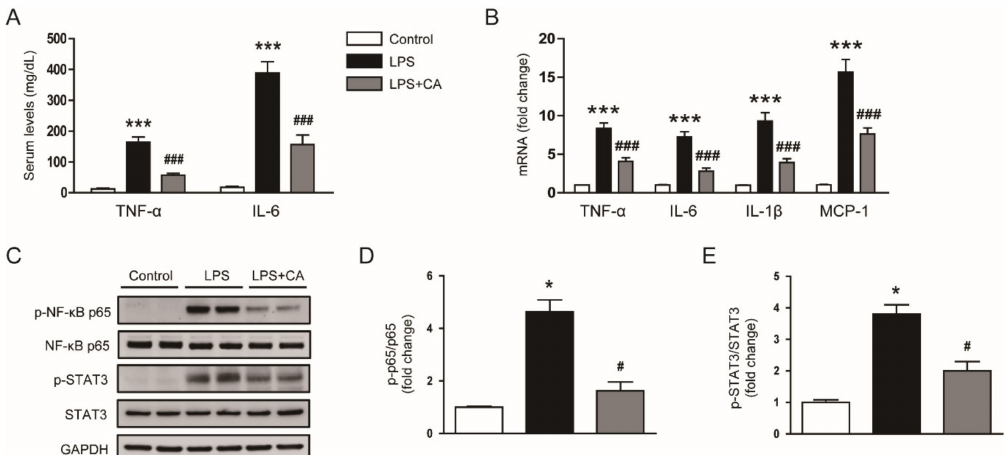
Figure 4. Effect of carnosic acid on cytokine production. ( A ) Serum TNF- α and IL-6 levels. ( B ) The mRNA expression of TNF- α , IL-6, IL-1 β , and MCP-1 in kidney tissues. ( C ) Western blotting of p-NF- κ B p65 and p-STAT3 in kidney tissues. ( D ) Quantification of Western blot data for p-NF- κ B p65. ( E ) Quantification of Western blot data for p-STAT3. n = 8 per group. * p < 0.05 and *** p < 0.001 versus control. # p < 0.05 and ### p < 0.001 versus LPS.